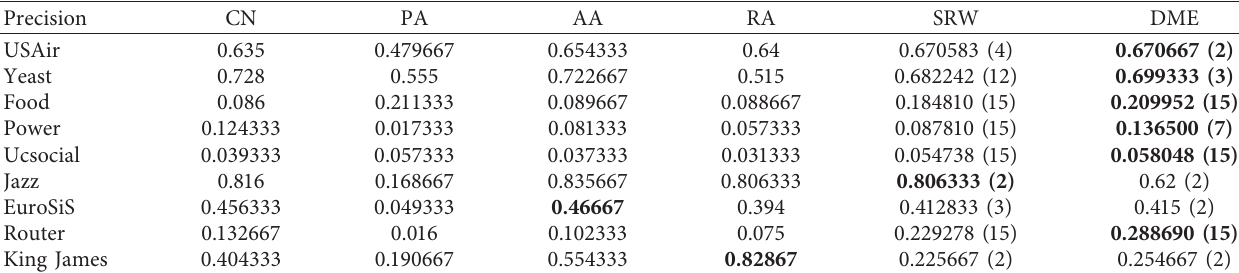
Table 2: Precision on the nine benchmark networks in the case of L �